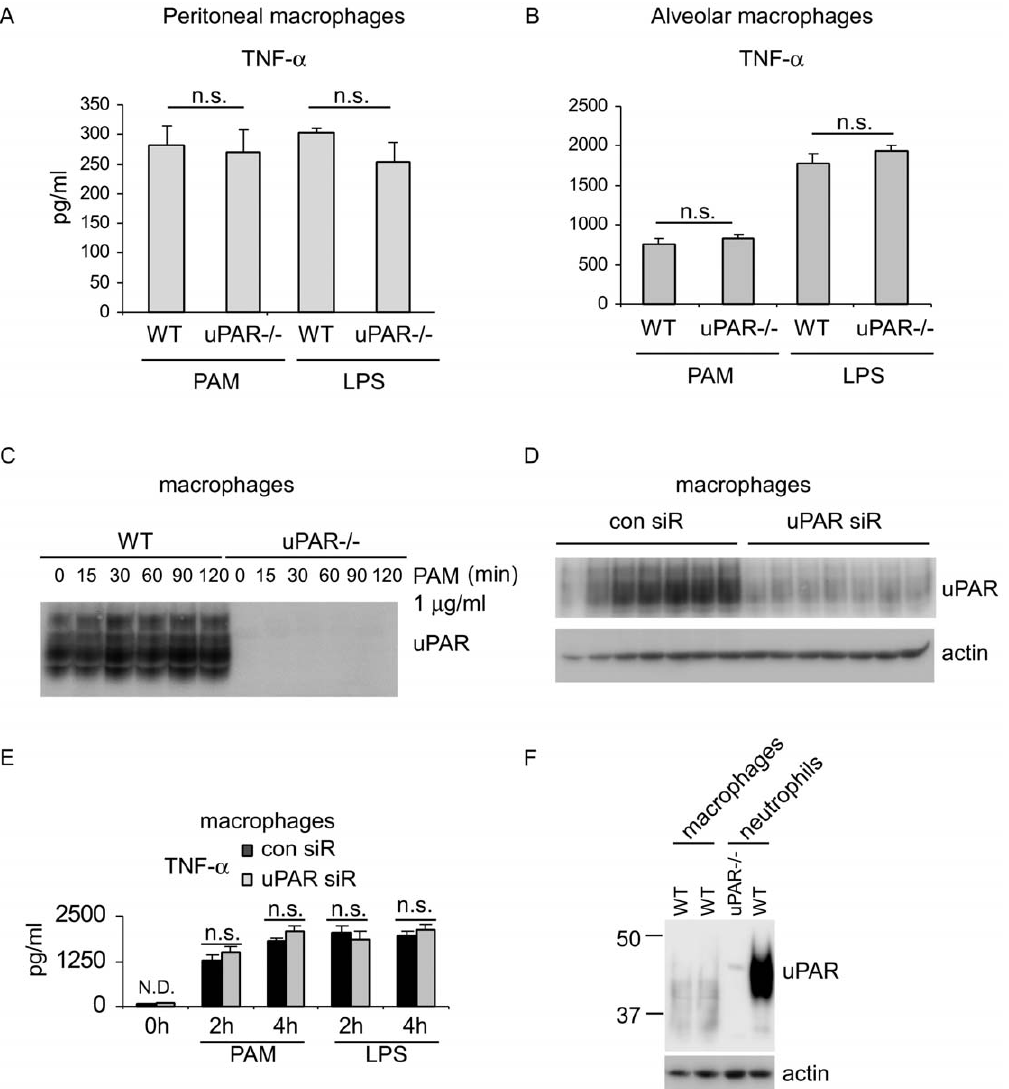
Figure 7. uPAR does not participate in TLR2 or TLR4 induced macrophage activation. (A) 0.25 6 10 6 WT and uPAR-/- peritoneal macrophages were treated with 1 m g/ml PAM or 10 ng/ml LPS for 4 hours and the levels of TNF- a in the supernatants determined. (A) 0.2 6 10 6 WT and uPAR-/- alveolar macrophages were treated with 1 m g/ml PAM or 10 ng/ml LPS for 4 hours and the levels of TNF- a in the supernatants determined. (C) 1 6 10 6 WT and uPAR-/- macrophages were treated with 1 m g/ml PAM for 0, 15, 30, 60 or 120 minutes. The cells were collected and cellular extracts prepared. The levels of uPAR were determined by Western blotting. (D) 1 6 10 6 WT and uPAR-/- macrophages were transfected with control siRNA or uPAR siRNA. Three days after transfection, the cells were collected and the levels of uPAR and actin determined by Western blotting. (E) 1 6 10 6 WT and uPAR-/- neutrophils were transfected with control or uPAR siRNA. Three days after transfection, the cells were treated with 1 m g/ml PAM or 10 ng/ml LPS for 0, 2, or 4 hours and TNF- a levels in the supernatants measured. (F) The levels of uPAR and actin in WT and uPAR-/- neutrophils and WT macrophages were determined by Western blotting. Results in A, B, C and F were representative of three independent experiments. Mean 6 SD; All p values were greater than 0.05. n.s. indicates statistically non-significant differences between